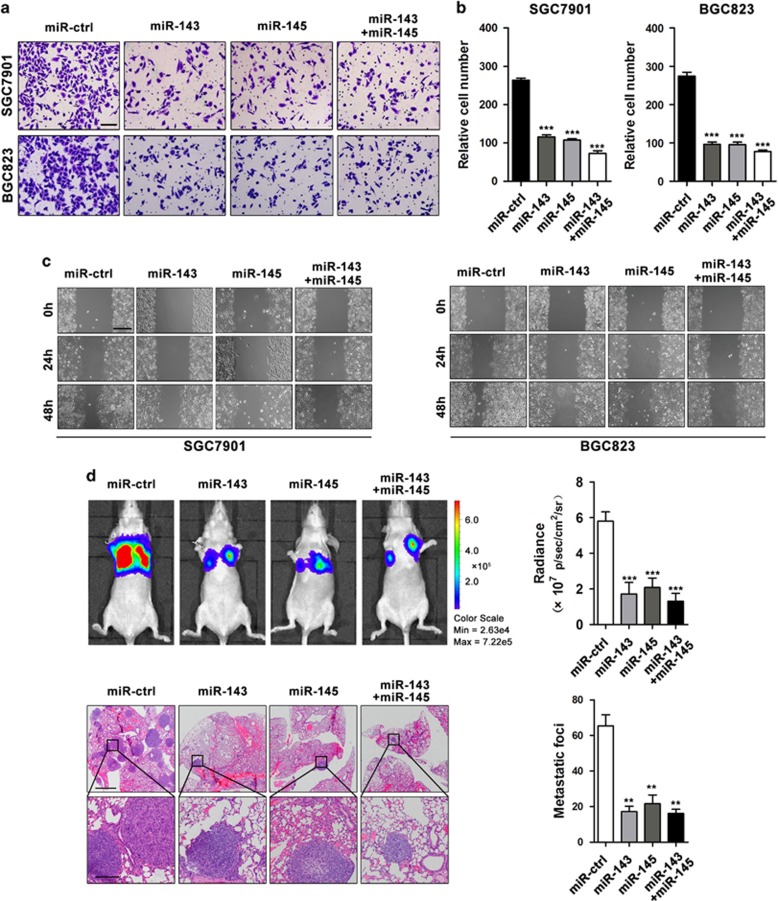
miR-143 and miR-145 inhibit GC cell migration and metastasis in vitro and in vivo. (a,b) Transwell assays of SGC7901 and BGC823 cells transfected with miR-143 and/or miR-145 mimics or miR-ctrl, scale bar: 100 μm. (c) Wound-healing assays of SGC7901 and BGC823 cells transfected with miR-143 and/or miR-145 mimics or miR-ctrl, scale bar: 400 μm. (d) Representative BLI images and H&E staining images of lung tissue sections from nude mice injected with BGC823 cells stably expressing miR-143 and/or miR-145, or miR-ctrl, scale bars: 500 μm (top) and 200 μm (bottom). **P<0.01, ***P<0.001